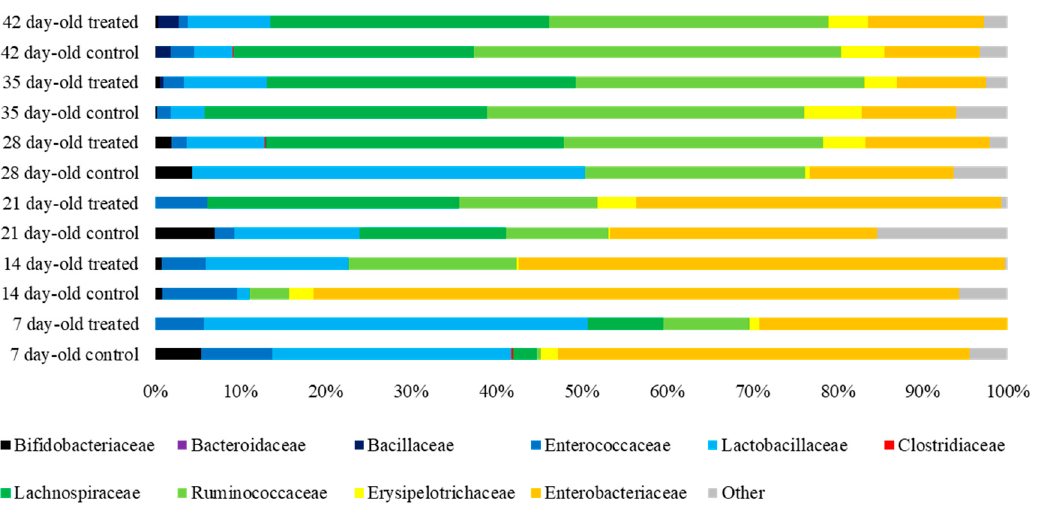
Figure 6. Bar chart showing the 10 most abundant bacterial families found in the cecal content of control and treated broiler chickens challenged with Salmonella Typhimurium at 21 days of life. Each bar represents the relative abundance (horizontal axis) of bacterial families by group of animals, diet treatment, and age.